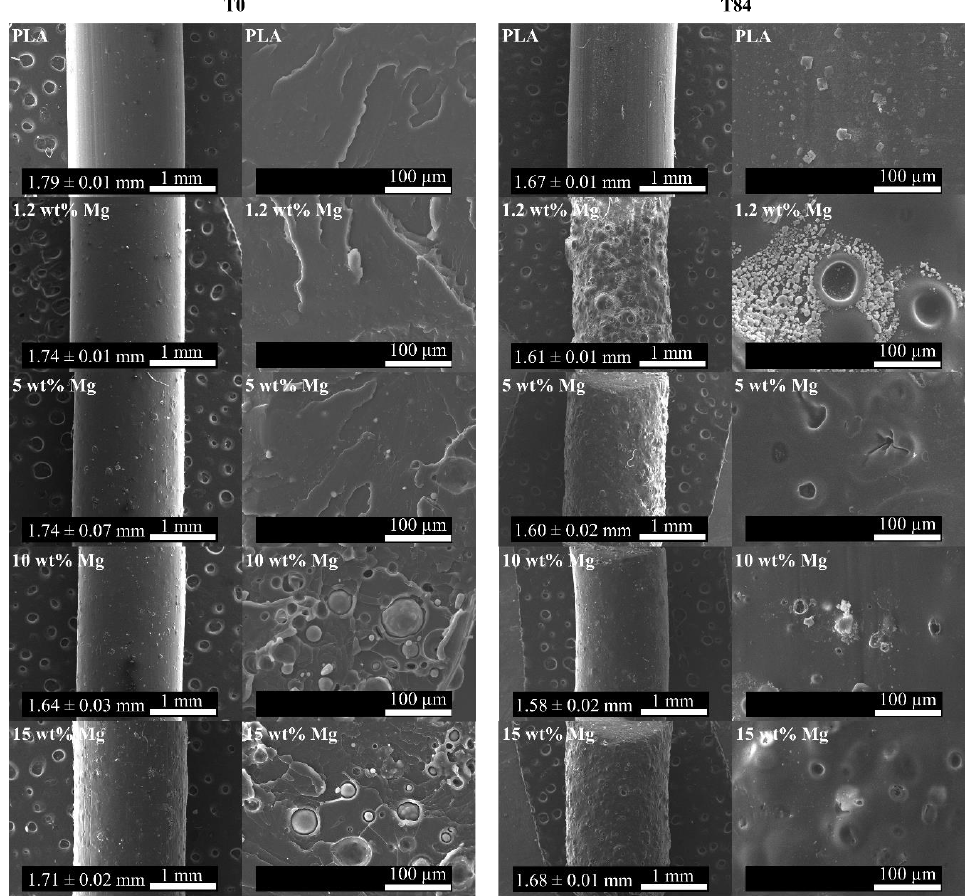
Figure 6. SEM images of PLA-Mg filaments and their fracture surface both at T0 and T84. As can be appreciated, the PLA-Mg filaments after 84 days of immersion in PBS showed an irregular surface with a high number of holes and no presence of Mg micro- particles. Remarkably, this phenomenon is observed in the 1.2 wt% Mg filament, which showed the highest eroded surface of all samples. Moreover, the immersion in PBS pro- voked the precipitation of salts deposited on the surface of the PLA-Mg filaments after 84 days. Parallel to the SEM study, a visual appearance study was carried out to visualize the color changes of the PLA-Mg filaments every seven days, as shown in Figure 7.